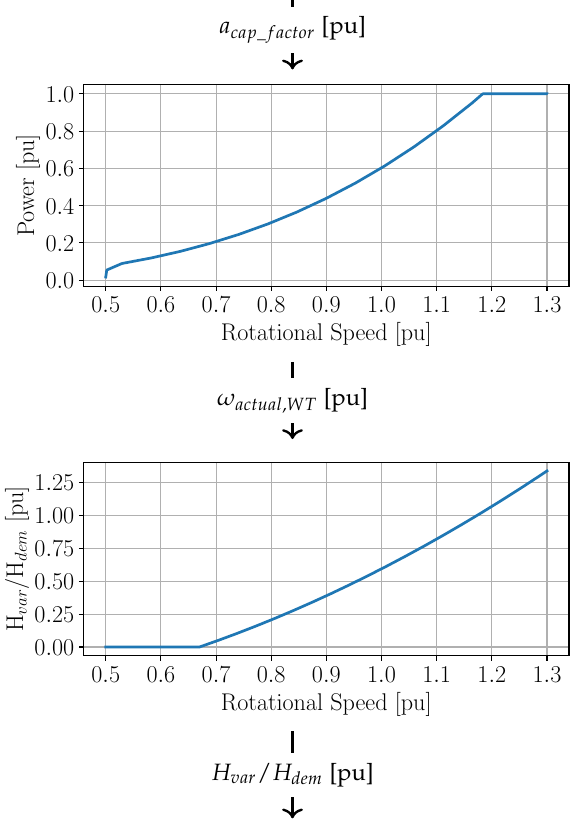
Figure 2. Two step methodology to determine H var / H dem applying the normalised power vs. nor- malised rotational speed characteristic of the NREL 5MW WT [33] and the normalised characteristics of the variable H controller [19]